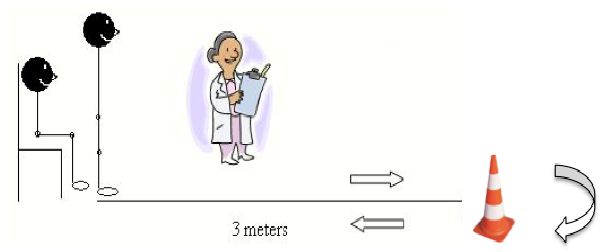
Figure 1: The Timed up and go test.